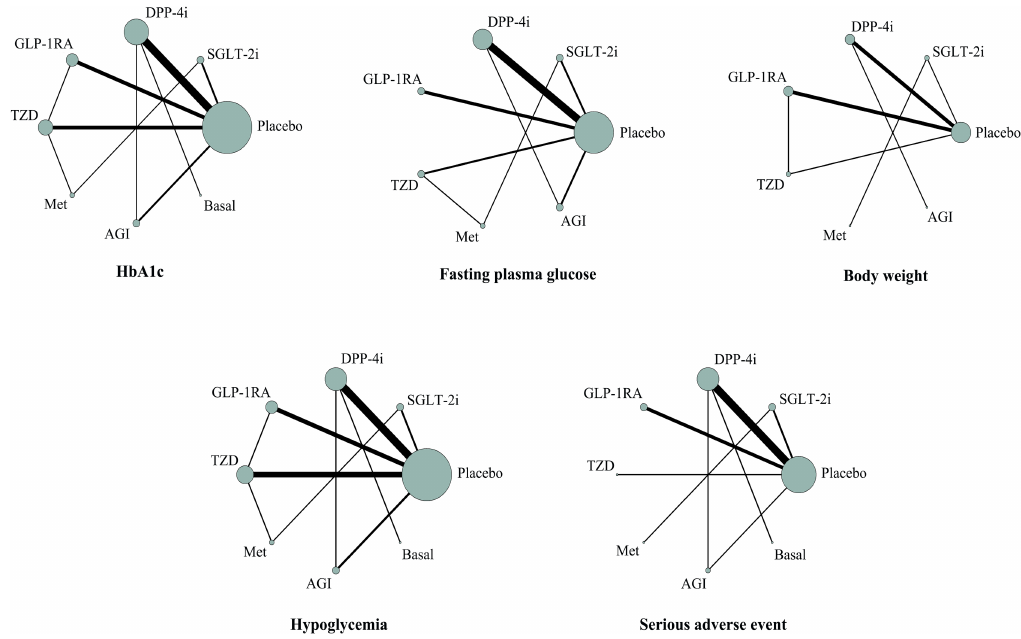
Fig 2. Network maps for efficacy and safety outcomes. Note: Connecting lines represent direct comparisons between the pairs of treatments, and the line widths represent the numbers of trials. The node sizes represent the overall sample sizes of the interventions. HbA1c, glycated hemoglobin; FPG, fasting plasma glucose; SGLT-2i, sodium-glucose co-transporter-2 inhibitor; DPP-4i, dipeptidyl peptidase-4 inhibitor; GLP-1RA, glucagon-like peptide-1 receptor agonist; TZD, thiazolidinedione; Met, metformin; AGI, α -glucosidase inhibitor; Basal, basal (long-acting) insulin.